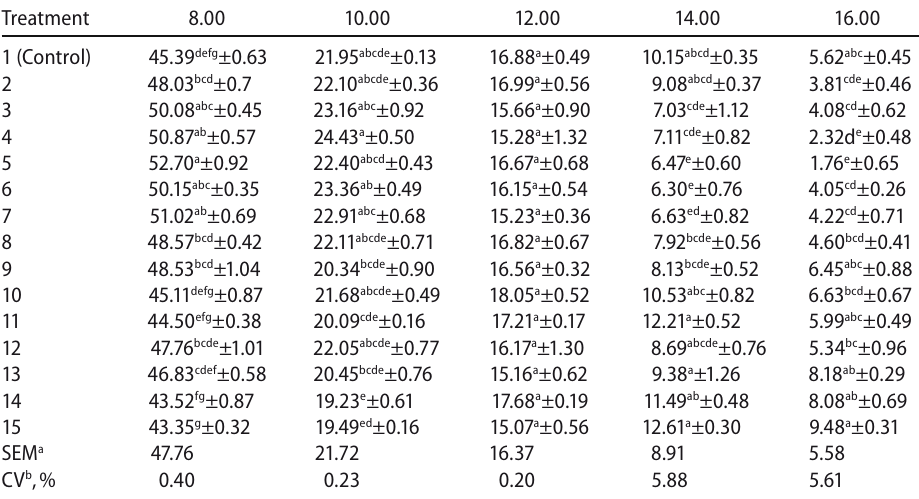
Effect of feeding time and frequency on the mean (±SE) of egg production (%) in broiler breeder from 8.00 to 16.00